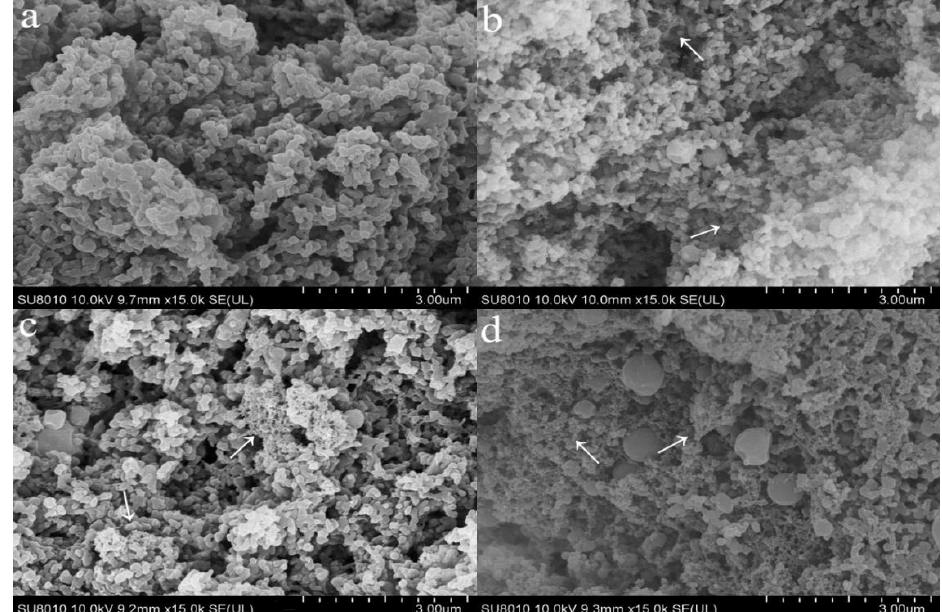
Figure 3. Scanning electron microscopy micrographs of rennet induced curds. a , control; b , S3; c , L3; d , H3 (magnification: ×15,000) (The arrow denotes soy protein and its hydrolysate).